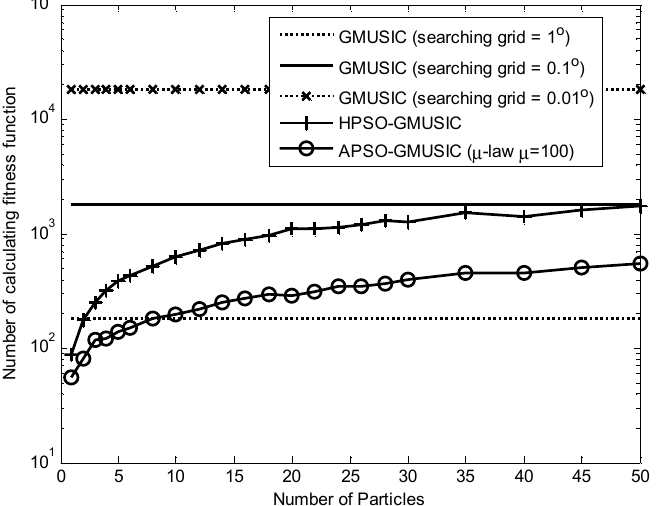
Figure 4. The required number of calculating fitness function ( B ) versus number of particles.